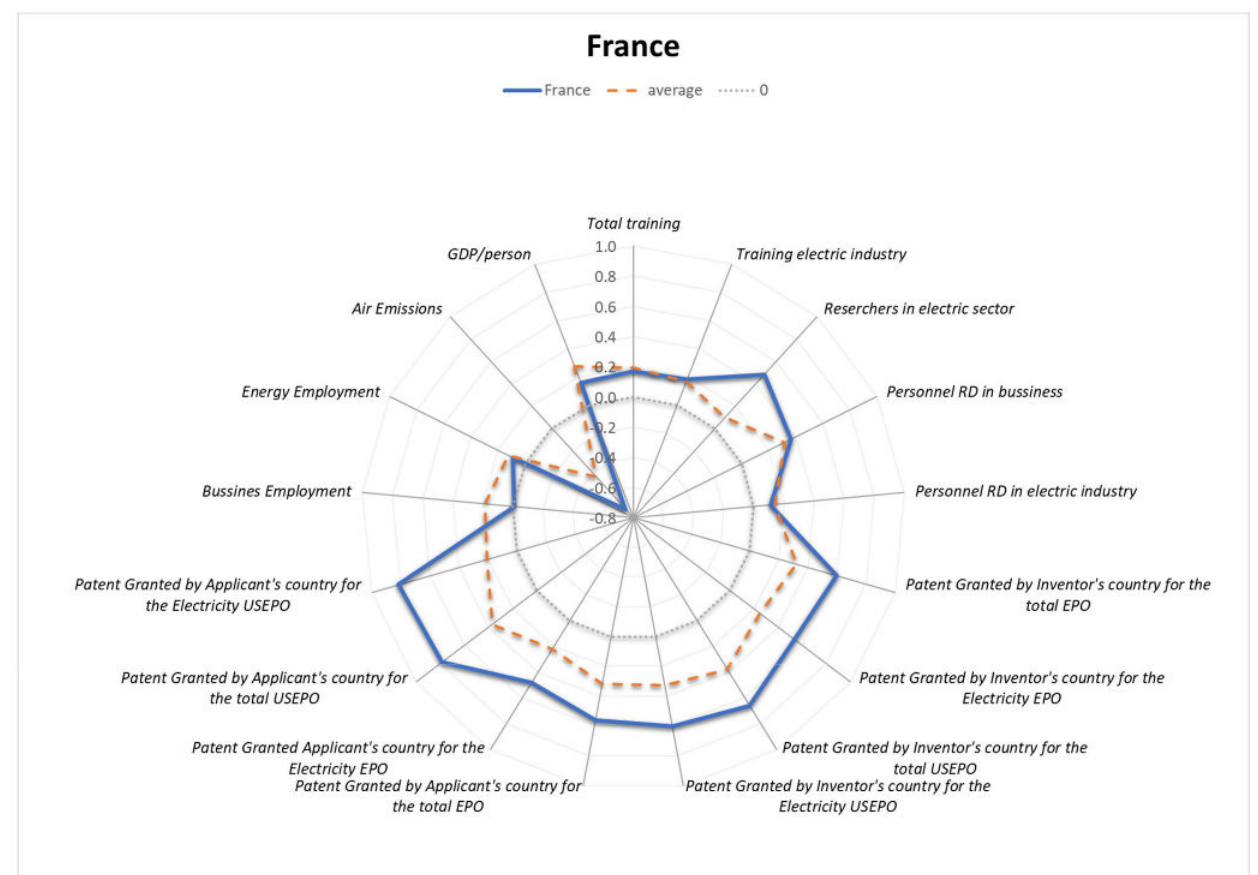
Figure 17. Synergy and trade-off occurrence—FR. Source: Authors’